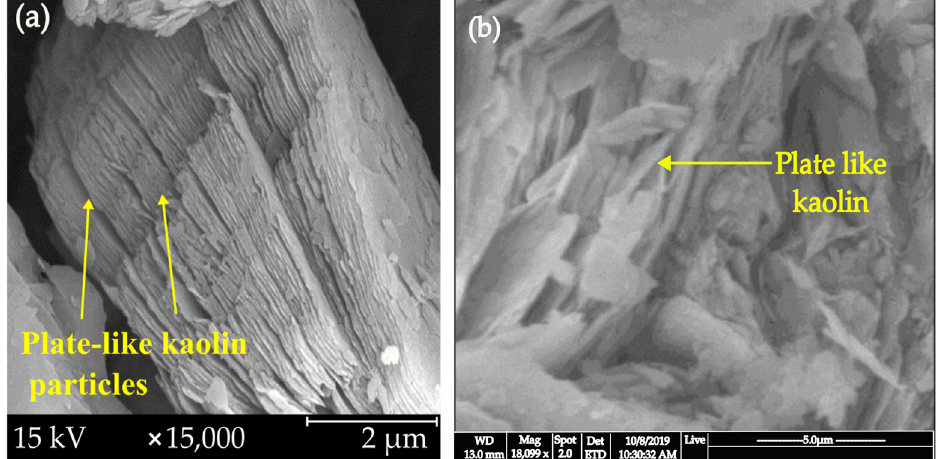
Figure 7. SEM images of the plate like kaolin ( a ) [111] ( b ) [79].